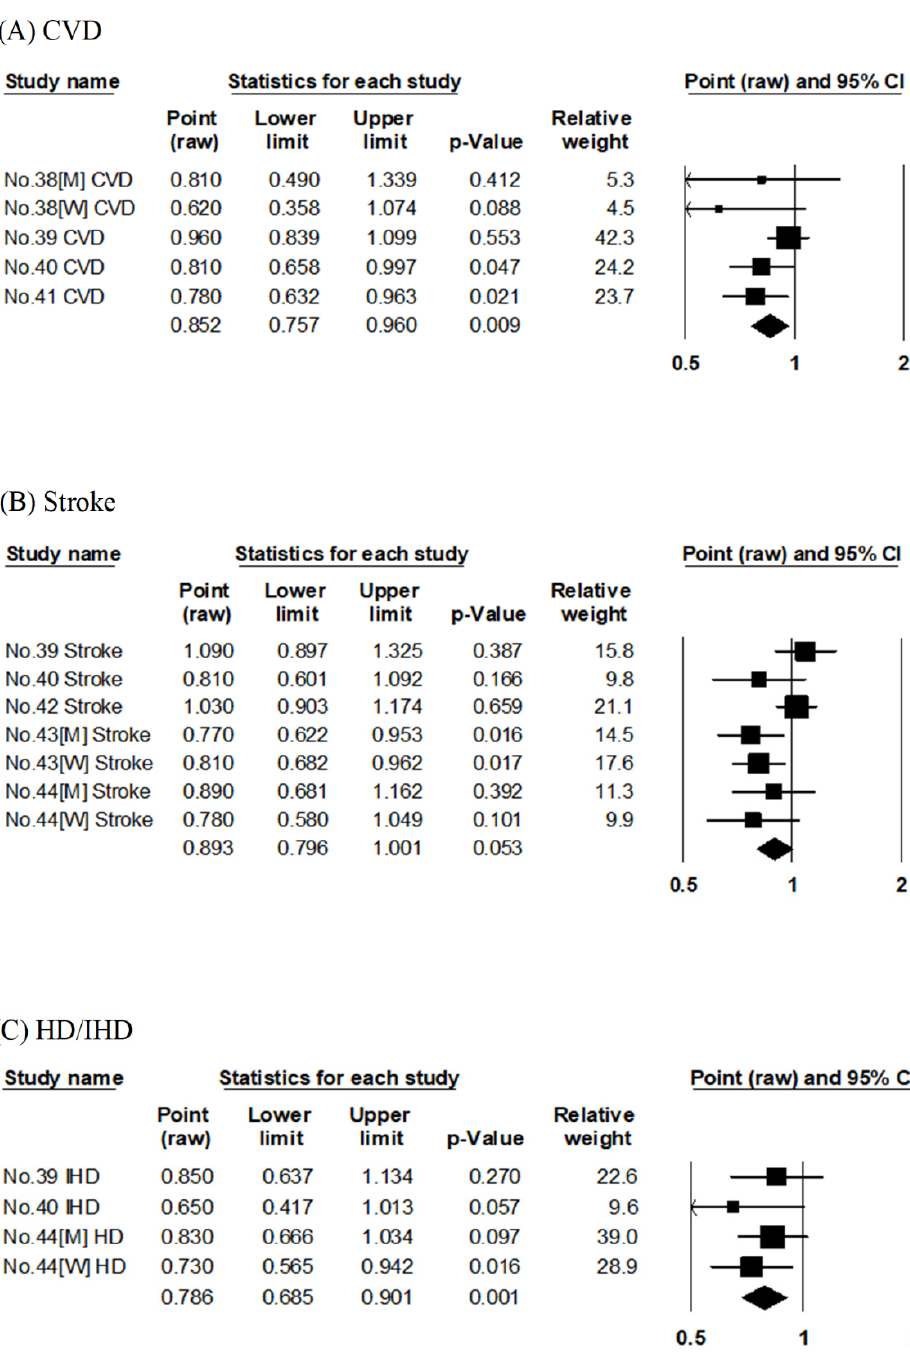
Figure 3. Meta-analysis of vegetable consumption and mortality risk. ( A – C ) show the association between vegetable consumption and CVD, stroke, and HD/IHD mortality risk, respectively. The area of each square is proportional to the study weight. Horizontal lines represent 95% confidence intervals. Diamonds represent pooled estimates from inverse-variance-weighted random-effects model. The number given in the study name indicates that of the cited reference [38–44]. CVD; cardiovascular disease, HD; heart disease, IHD; ischemic heart disease. Fruits Five articles evaluated the association between fruit consumption and risk of CVD mortality [38–41,45] (Table S3). They evaluated the results of three cohort studies (Takayama Study, JACC, and NIPPON DATA80). There were two reports each on NIPPON DATA80 [40,41] and JACC [39,45], but the reports of the same cohort differed in terms of